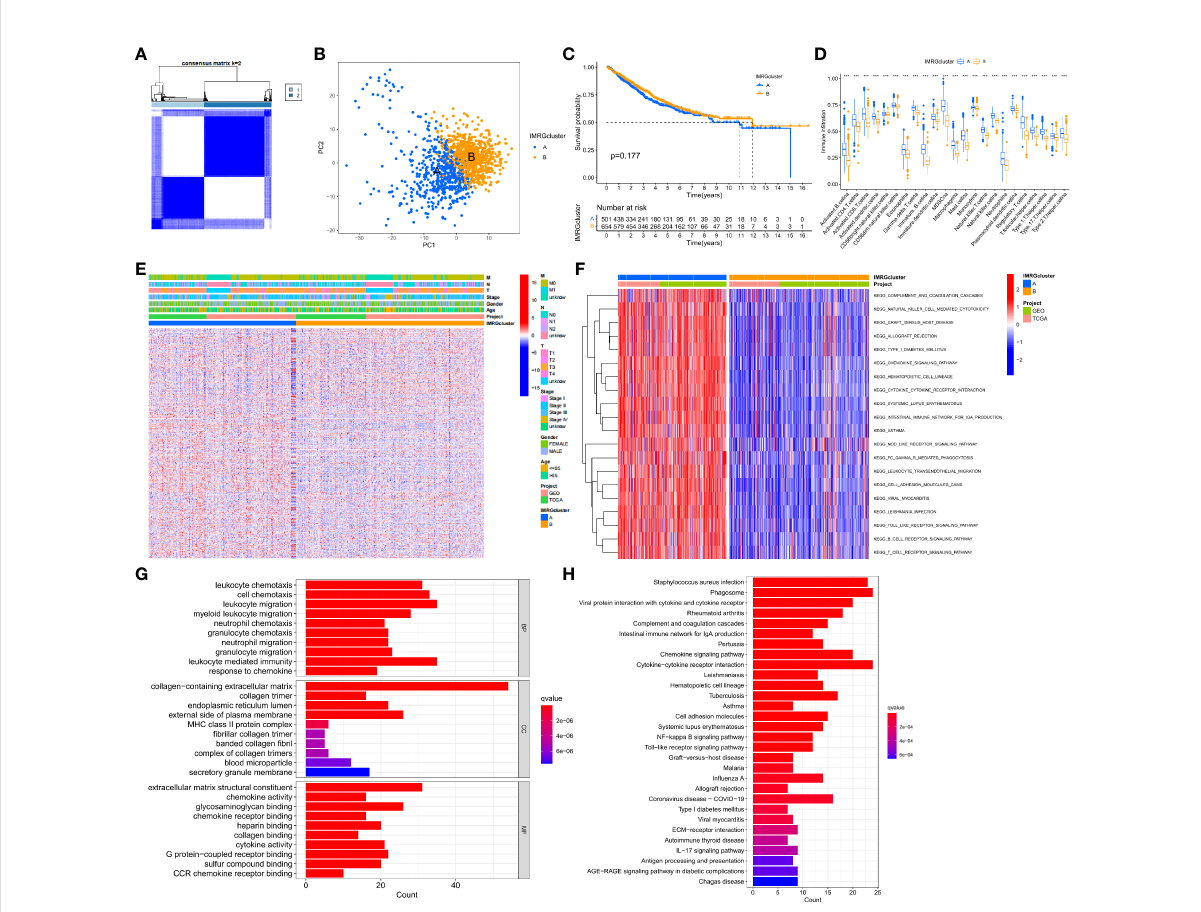
FIGURE 2 Subtype, clinicopathological, and biological characteristics of the IMRGs. (A) Consensus cluster analysis to construct the consensus matrix diagram of the two related regions; (B) PCA shows the difference between the two subtypes; (C) Comparative analysis of the OS rate between the two subtypes; (D) Differences in immune cell in fi ltration abundance between the two subtypes; (E) Heatmap of the differential clinicopathological features and IMRGs expression levels between the two different subtypes; (F) GSVA of the biological pathways between the two different subtypes, red: Activation pathway, blue: Inhibition pathway; (G,H) GO and KEGG analyses of DEGs between different IMRGs subtypes. ***p <